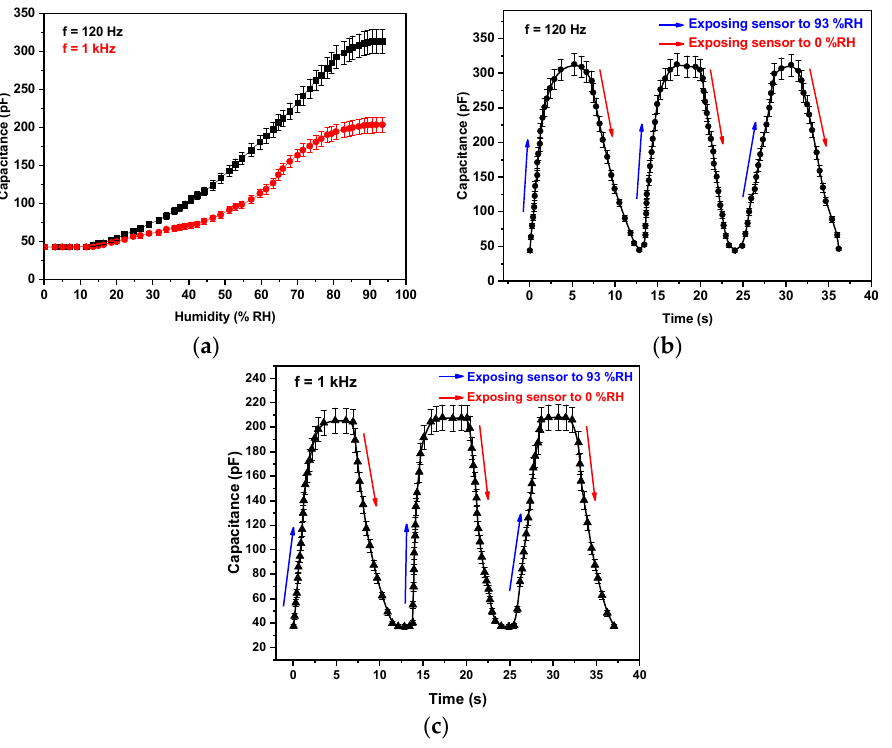
Figure 6. ( a ) Capacitance as a function of relative humidity (%RH) at 120 Hz and 1 kHz, ( b ) response/recovery-time curve at 120 Hz, and ( c ) response/recovery-time graph at 1 kHz for Ag/PAD/Ag sensor.